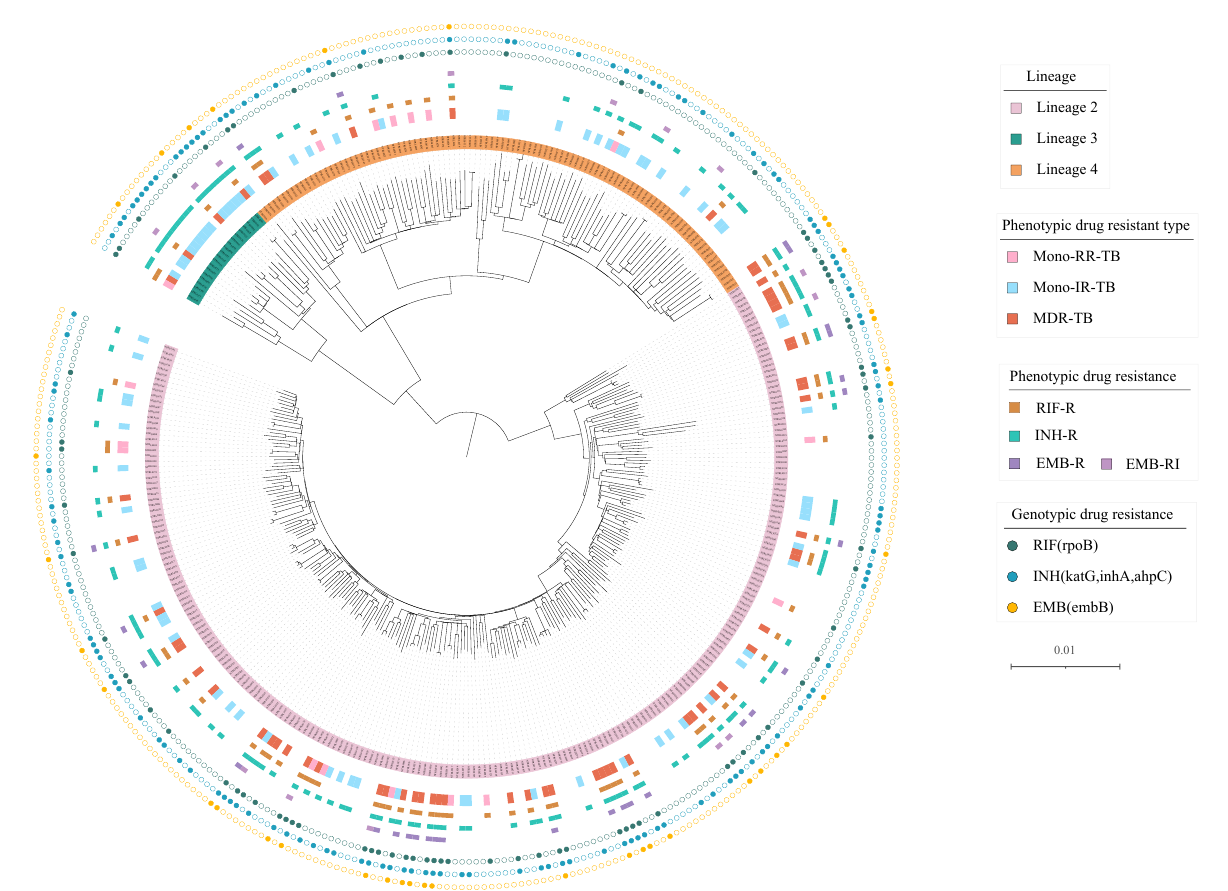
Figure 2. Maximum-likelihood tree of 353 MTB isolates and annotated with drug-resistance informa- tion. Note: Lineages, phenotypic drug-resistant type, and genotypic drug-resistant profile of isolates are